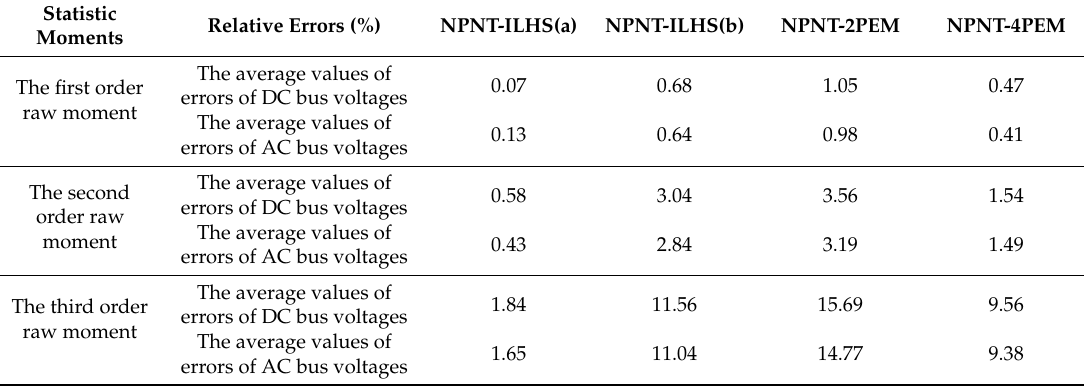
Table 7. The average values of relative errors (%) of DC bus and AC bus voltage magnitudes.